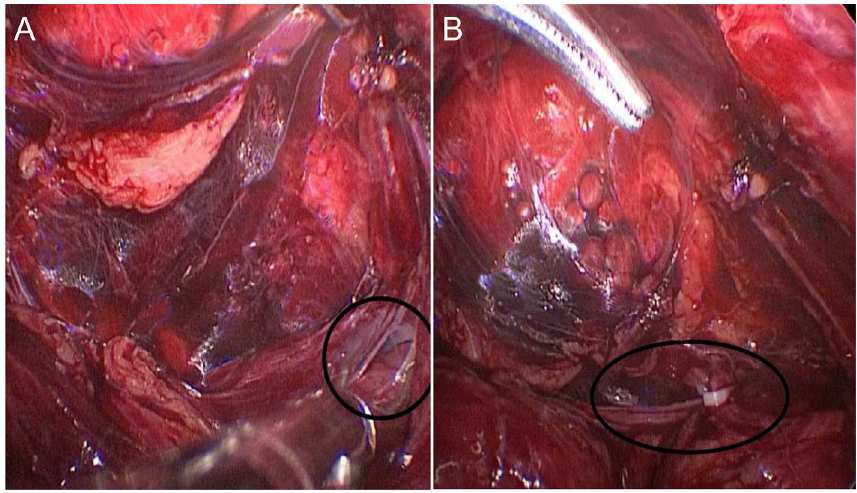
Figure 4. Treatment of peritoneal damage. Breaks larger than 2 cm can be closed with absorbable clips before